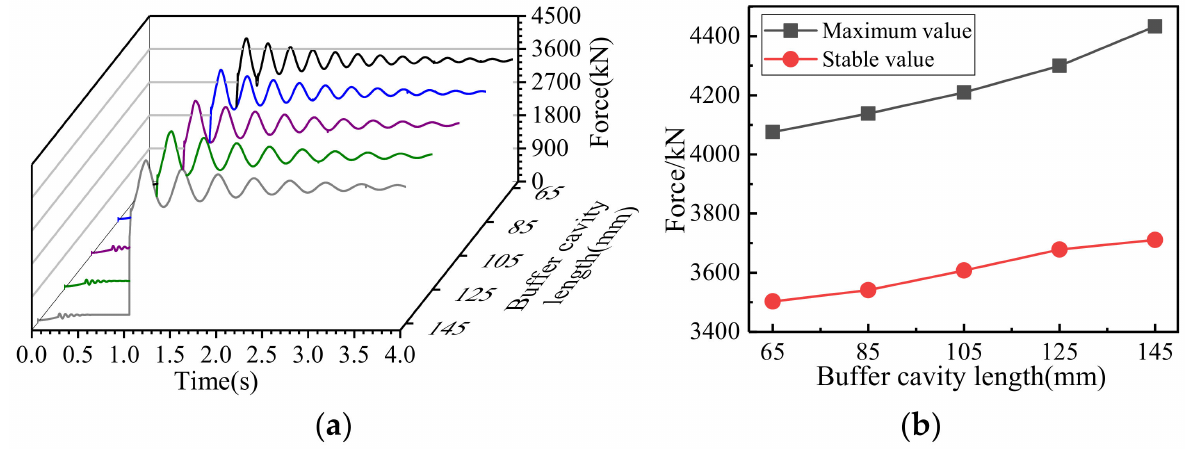
Figure 12. ( a ) The force comparison of hinge point between top beam and the balance jack. ( b ) Peak force and stable force of hinge point.